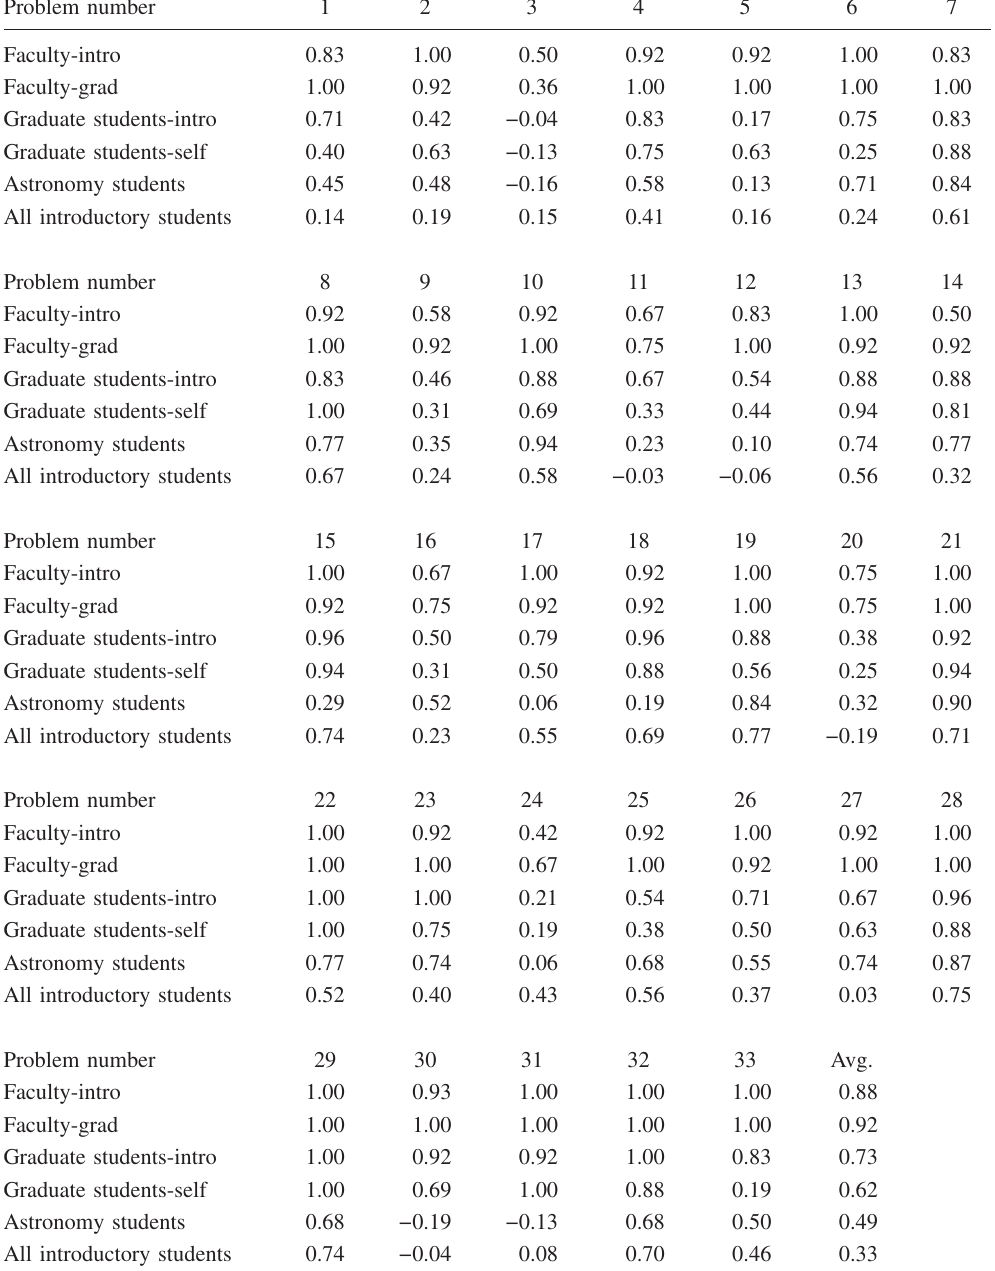
TABLE I. Average scores for each group of students and faculty on each of the individual questions and averaged over all survey questions (cid:1) see last entry (cid:2) . To calculate the average score for a question, a +1 is assigned to each favorable response, a −1 is assigned to each unfavorable response, and a 0 is assigned to neutral responses. One then averages these values for everybody in a particular group (cid:1) e.g., faculty-Intro (cid:2) to obtain an average score for that group. “Intro” and “Self” with Graduate students implies problem solving in “introductory physics” and “graduate-level physics courses”